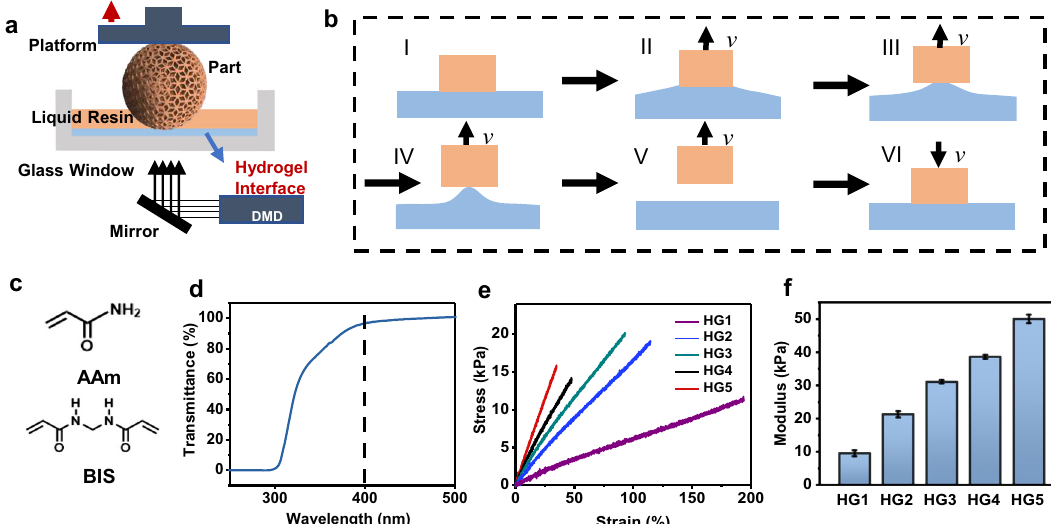
Fig. 1 Setup, process, and hydrogels. a Schematic demonstration of the DLP printing process equipped with a hydrogel layer as the separation interface between the glass window and the liquid resin. b Schematic process of the peeling-based separation on a soft and deformable interface. c Chemical structures of the monomers for the hydrogel. d Transparency of the curing window composed of the glass tank and the hydrogel layer. e Tensile stress- strain curves of the hydrogels with different compositions. f Tensile modulus of different hydrogels. Error bars: Standard Deviation ( n =